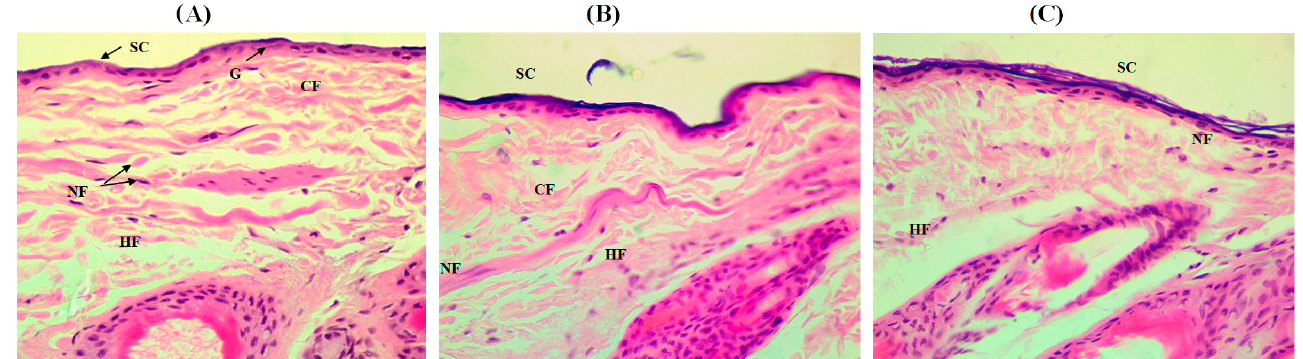
Figure 10. A Photomicrograph of ( A ) normal skin of control group, ( B ) skin specimen treated with F0, and ( C ) skin specimen treated with the optimized formulation. All samples were stained with standard Hematoxylin and Eosin. SC: stratum corneum, NF: neutrophil infiltration, G: granulosum,